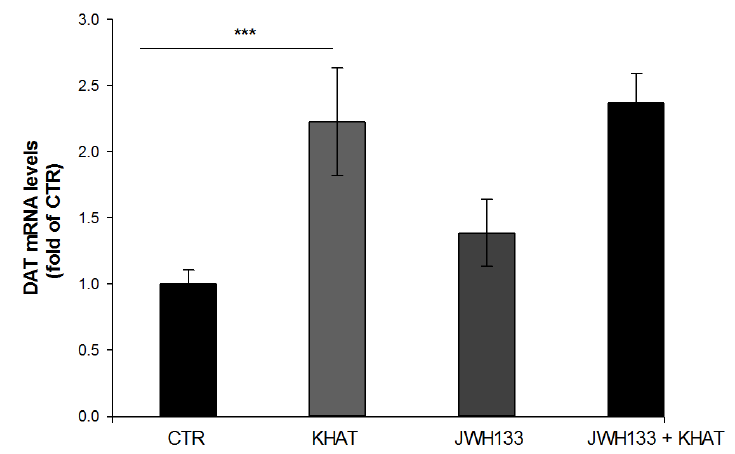
Figure 6. Effect of sub-acute administration of khat extract alone and in combination with JWH133 on DAT mRNA gene expression in WT mice. The quantification of dopamine transporter (DAT) mRNA levels and normalized by GAPDH mRNA in the VTA of WT mice after the administration of khat extract. Values are mean ± SEM (n=6 in each group). Statistical analysis was done using one-way ANOVA followed by Tukey ′ s multiple comparison test. *** p < 0.001. CTR (control group received the vehicle); KHAT (treatment group received khat extract 300 mg/kg); JWH133 (treatment group received JWH133 5 mg/kg); JWH133 + KHAT (treatment group received a combination of JWH133 5 mg / kg with khat extract 300 mg / kg). The vehicle, JWH133, and khat extract were administered to mice once daily for seven consecutive